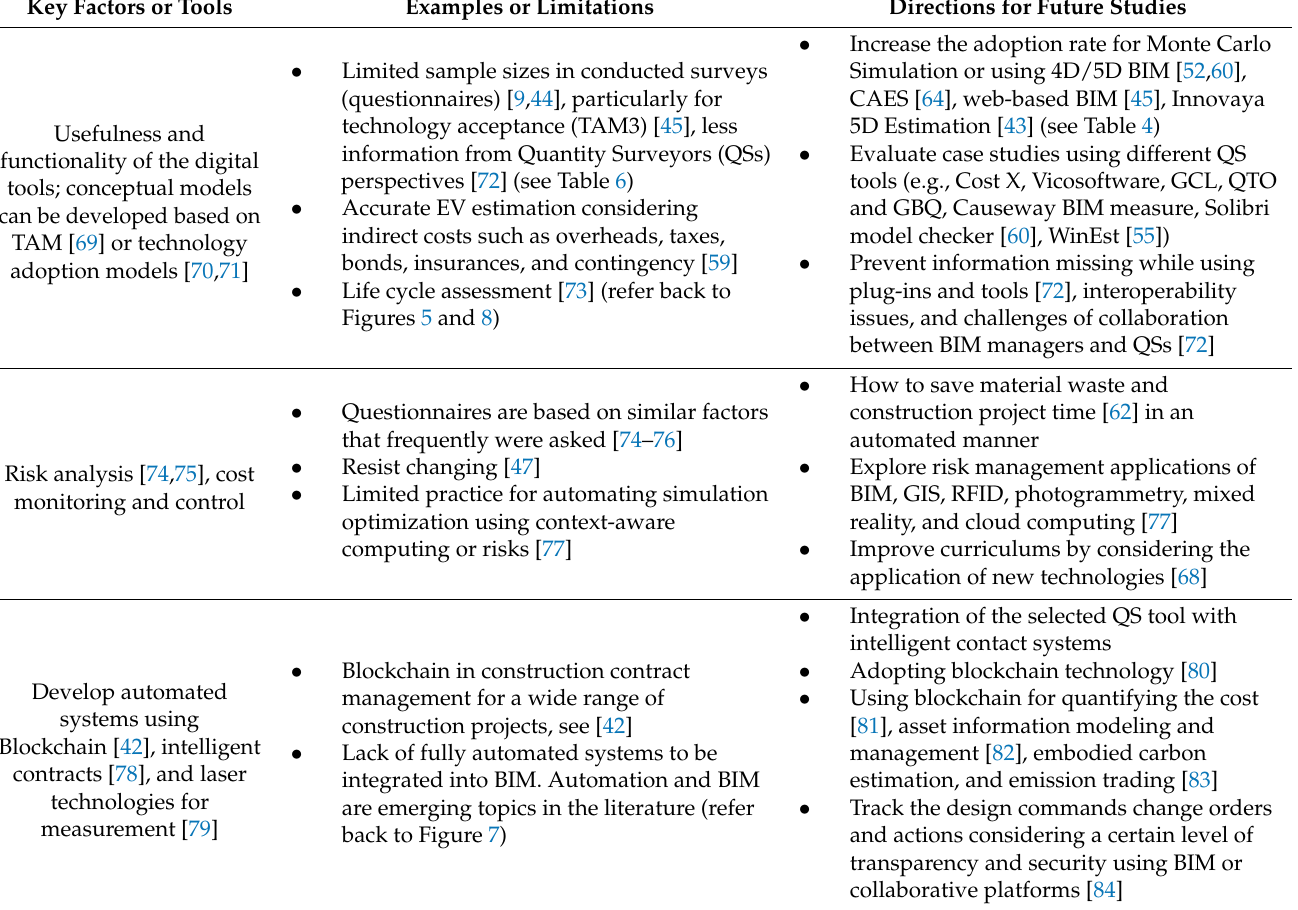
Table 8. Future directions based on deficiencies of the current cost management in response to industry 4.0